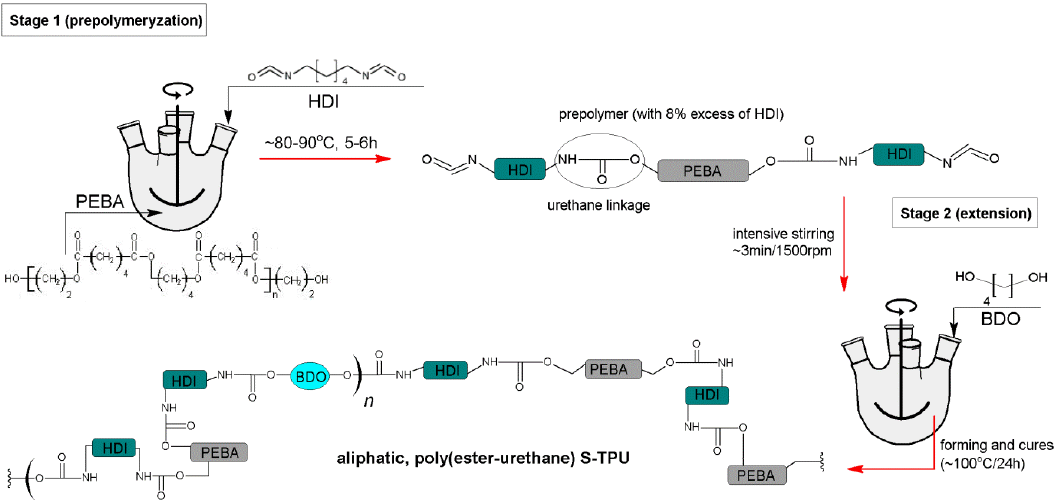
Figure 1. S-TPU synthesis scheme.